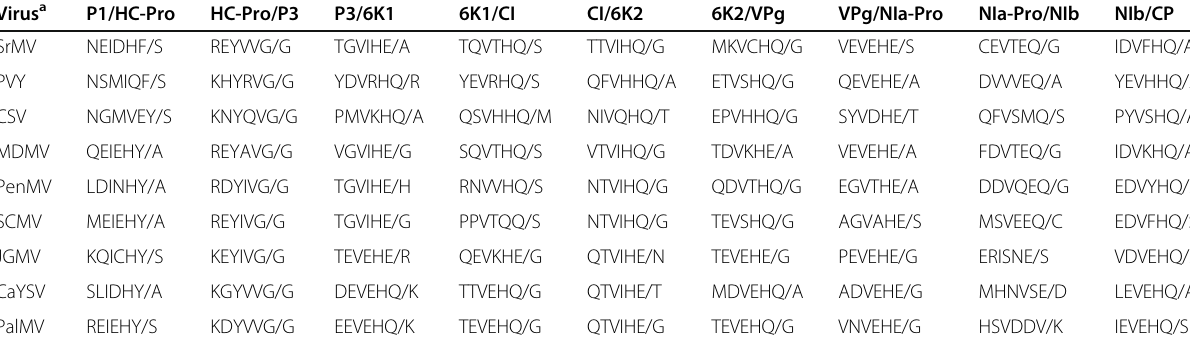
Table 1 Comparison of the cleavage sites of the polyprotein among PalMV and some related potyviruses Virus a